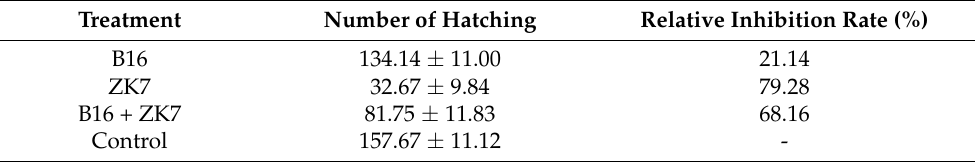
Table 4. Influences of different treatments on eggs of M . incognita by ZK7. Treatment Number of